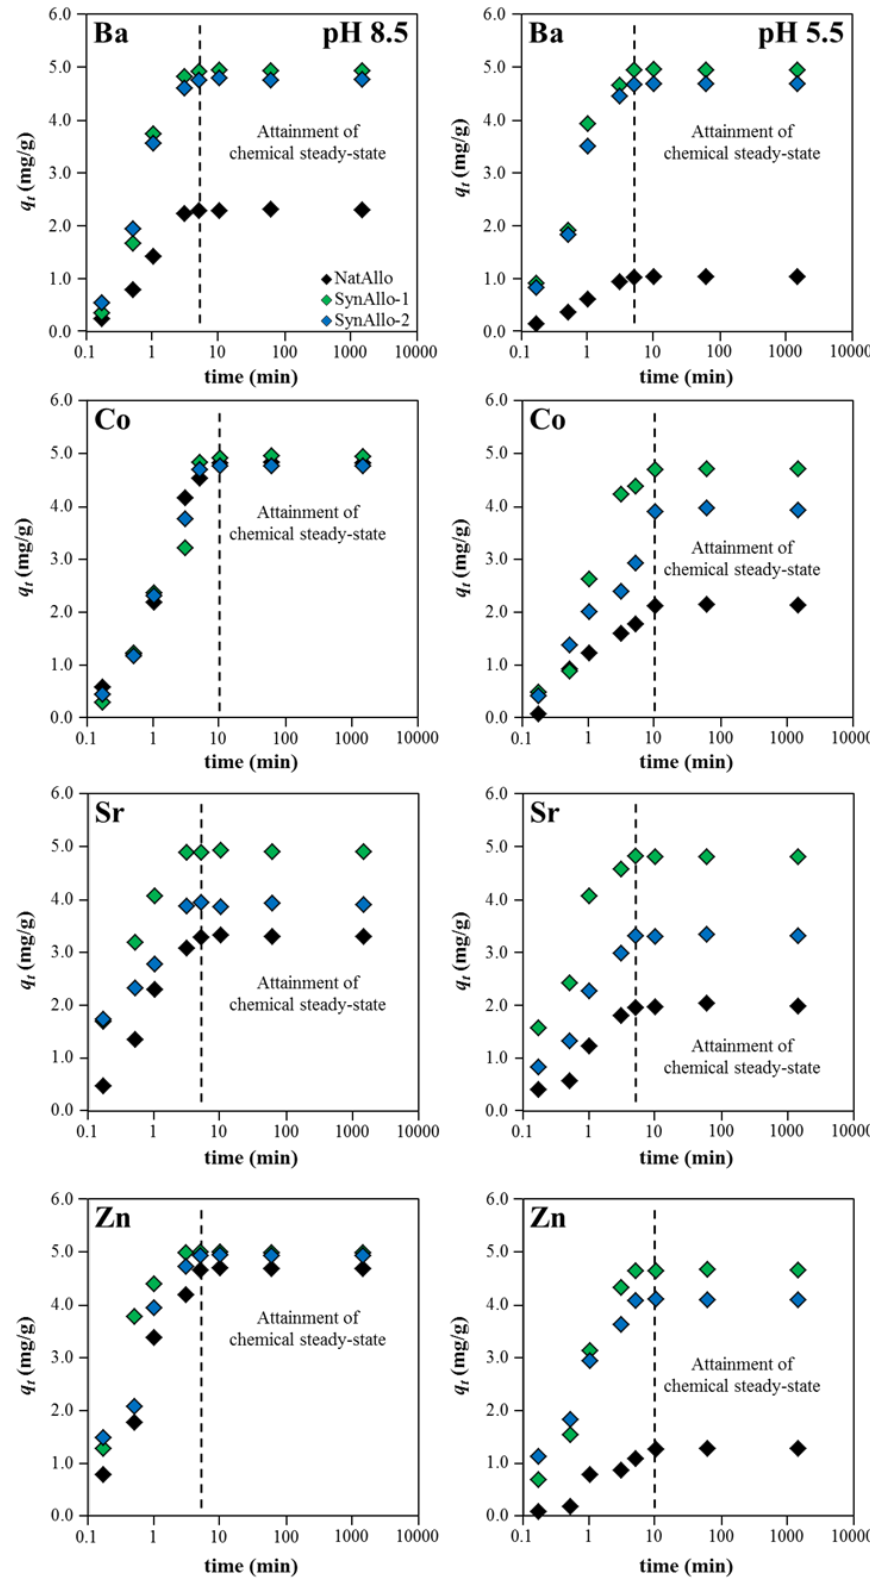
Figure 4. Effect of contact time on the adsorption behavior of aqueous metal ions (initial concentration: 10 mg/L; temperature: 25 °C) by natural and synthetic allophanes at pH 8.5 ( left panel ) and pH 5.5 ( right panel ).